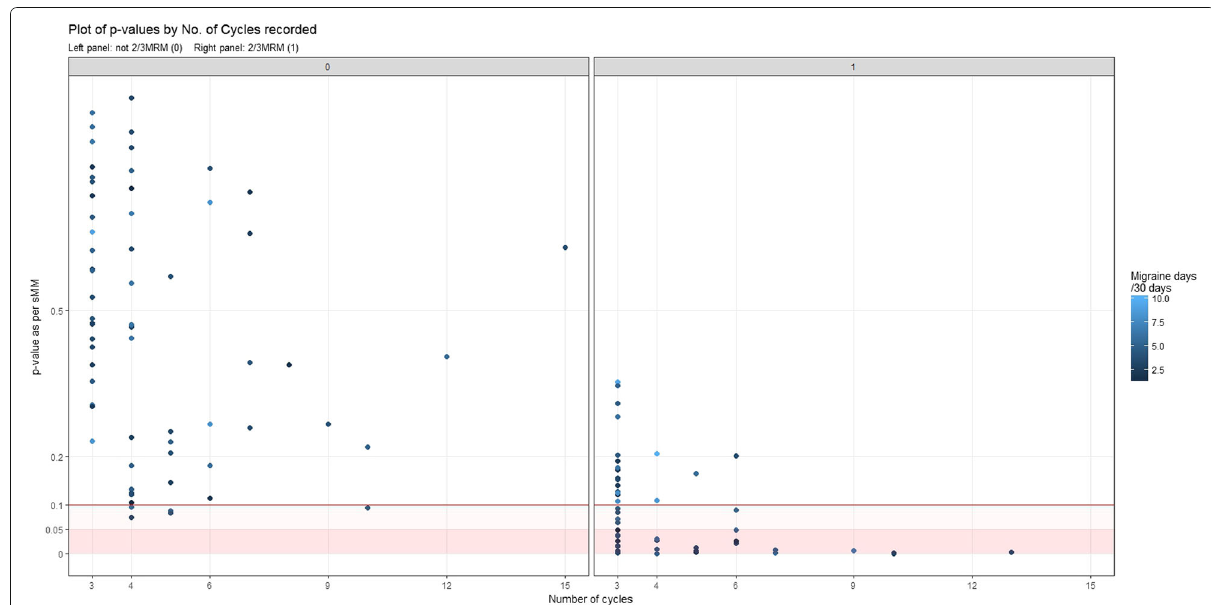
Fig. 6 Plot of the individual sMM p -values ( y -axis) against the number of cycles recorded ( x -axis). The left panel contains the women without a 2 MRM diagnosis, the right those with a 2 MRM diagnosis. The lighter the dot is, the lower is her estimated migraine frequency. We see that amongst 3 3 the women with an 2 MRM diagnosis, the p -values appear to be low when many cycles were observed, while the p -values for women with few 3 recorded cycles are more dispersed (along the y -axis). The women with relatively low p -values in the left panel represent women with low